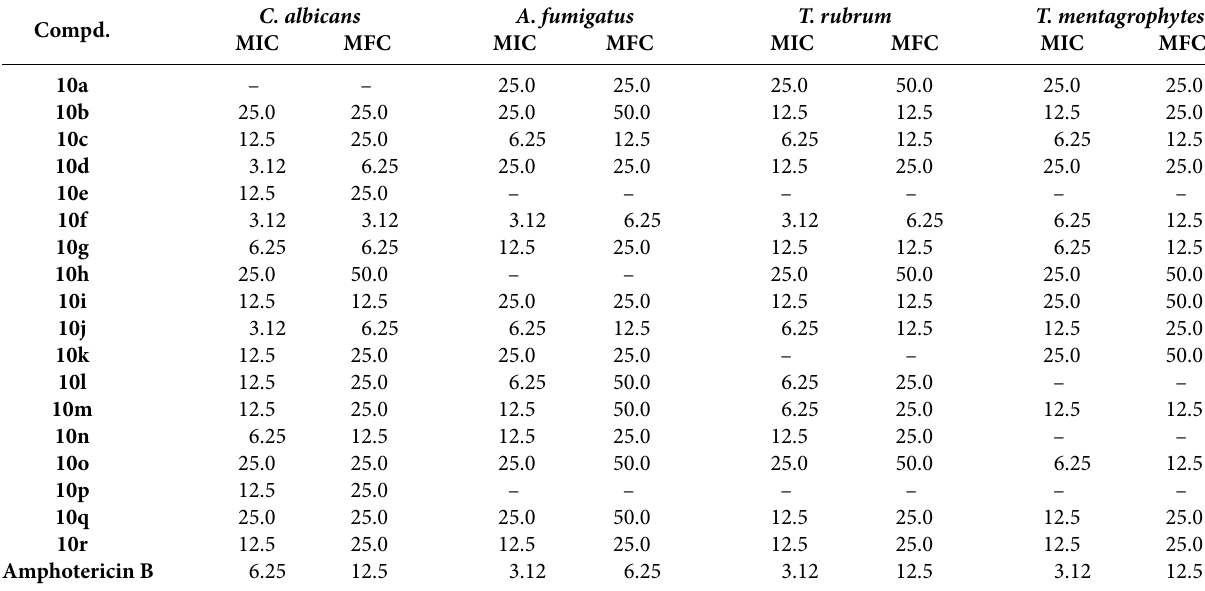
Table 4. Minimum inhibitory concentration (MIC) and minimum fungicidal concentration (MFC) in μg/mL of compounds 10a – r